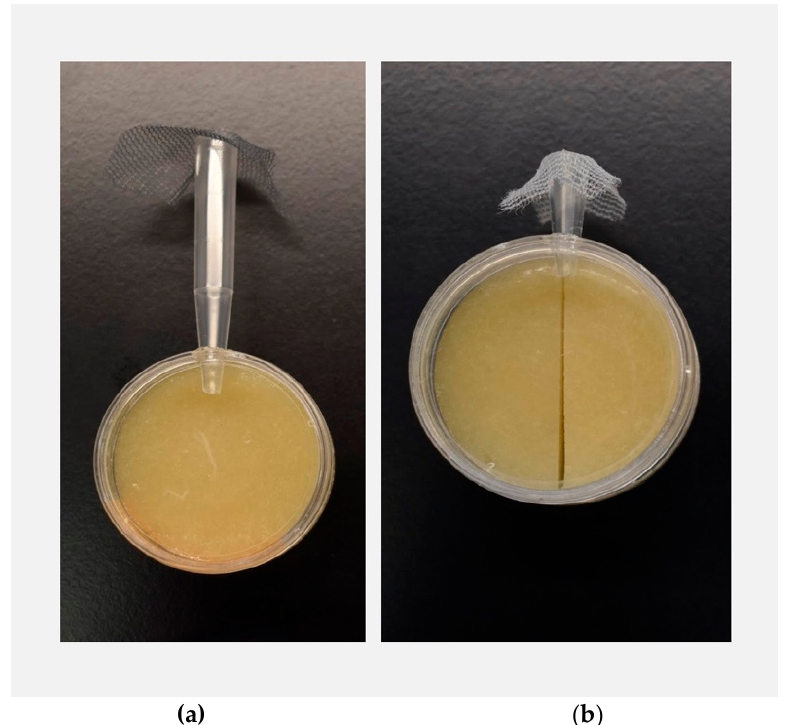
Figure 1. Environmental sampling (exploratory behavior) assay ( a ) and decision-making (habitat choice) assay ( b ): single flies were aspirated into the pipette tips, which were fitted into a small hole in the arena with plain fly food. A mesh barrier prevented each fly from escaping the pipette tip in the other direction. For the environmental sampling assay, each fly had the option to emerge into the arena or remain in the pipette tip. Each fly’s latency to emerge into the arena (in seconds) was recorded. For the decision-making assay, flies were allowed to emerge into the arena on their own accord and were then scan sampled every ten minutes over two hours, and food substrate choice of each fly was recorded.